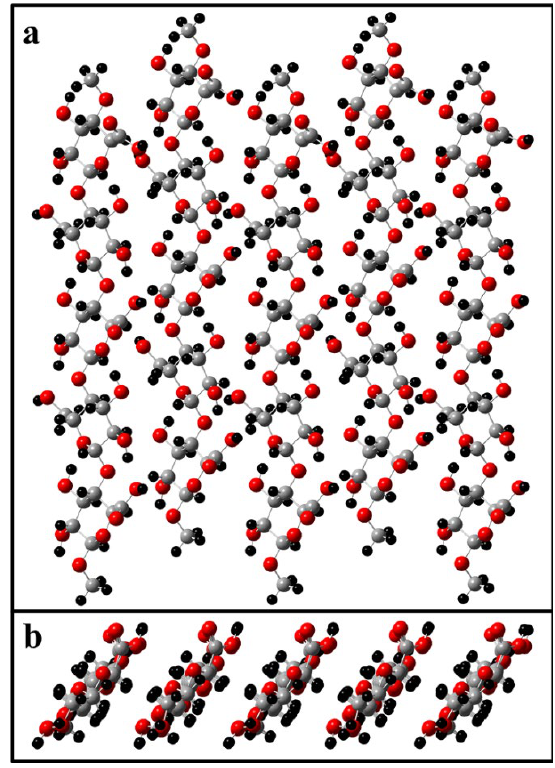
Figure 4. ( a ) Top-down view and ( b ) side view of the 5 × 5 TEMPO-oxidized transducer surface (( 1−10 ) crystal plane) model without attached biosensor. In this model, the grey atoms correspond to carbon, red is for oxygen, and black for hydrogen.